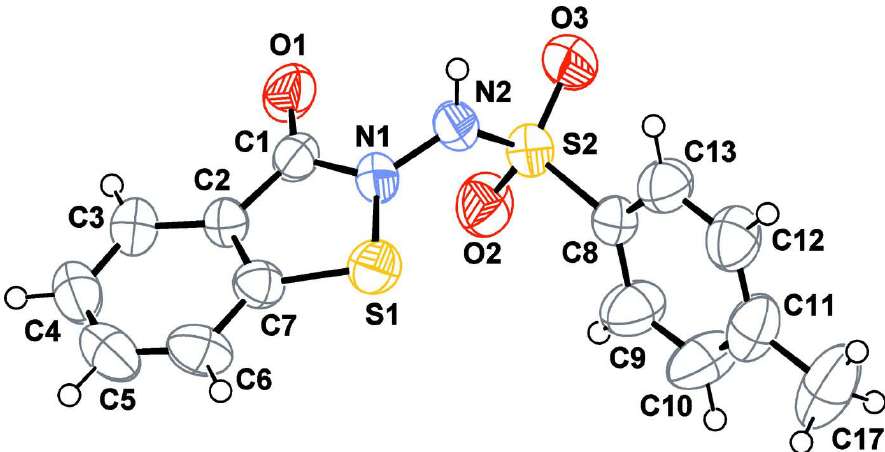
Figure 1 The molecular structure of the title compound, with displacement ellipsoids drawn at the 50% probability level.